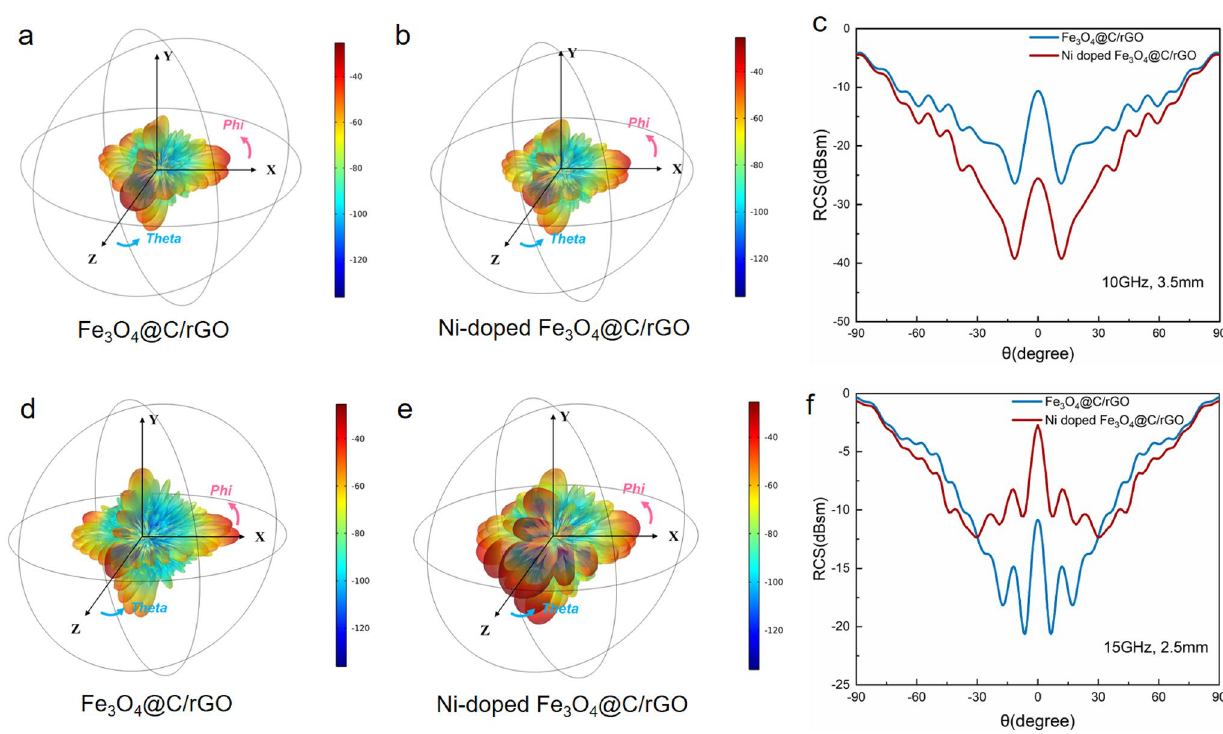
Fig. 8 a , b , d , e 3D radar wave scattering signals, c, f RCS simulated curves of the prepared Fe 3 O 4 @C/rGO and Ni-doped Fe 3 O 4 @C/rGO aero-